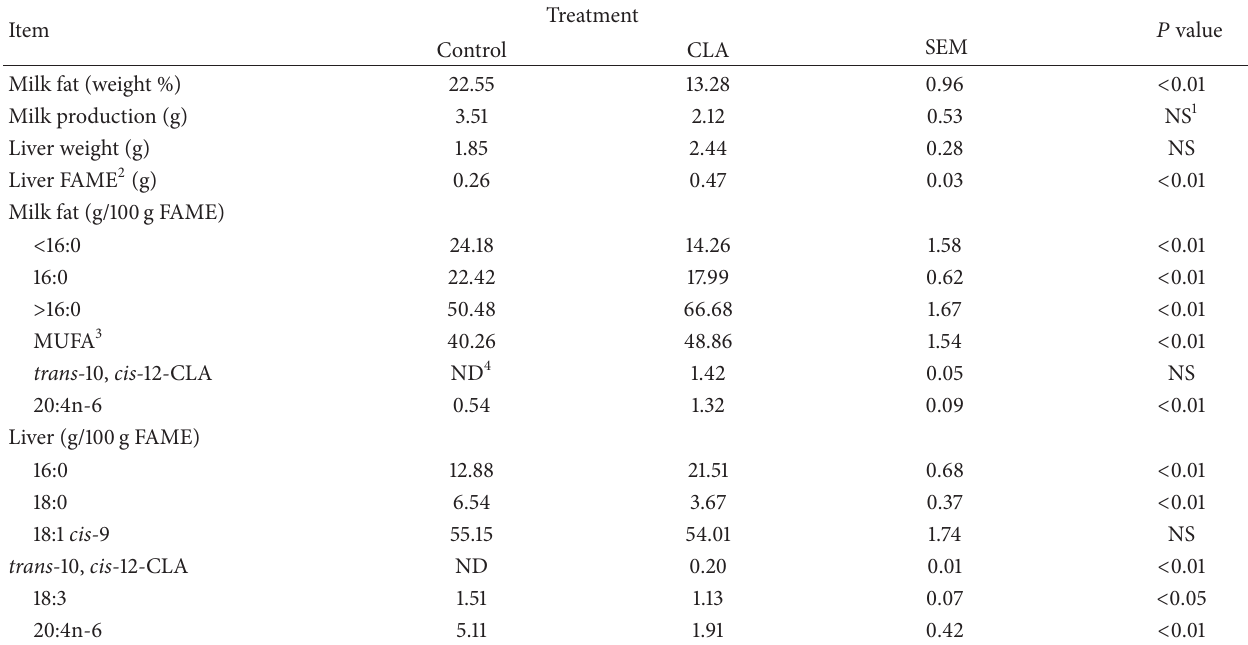
Table 2: Effect of trans -10, cis -12-CLA diet on milk production, milk lipid content, milk fatty acid profile, liver weight, and liver fatty acid